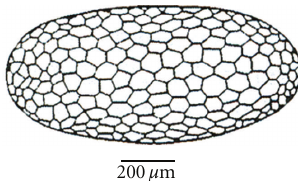
Figure 5: Neocrepidodera ferruginea , egg (after Blunck [23]).